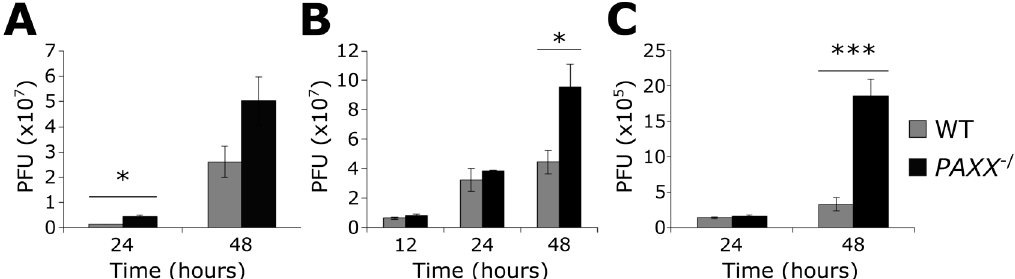
Figure 6. PAXX restricts production of infectious HSV-1 virions. WT or PAXX − / − RPE-1 cells were infected with HSV-1 at MOI ( A ) 0.01, or ( B ) 4, and infectious virions were titrated onto vero cells to determine virus titre (plaque-forming units; PFU); ( C ) WT or Paxx − / − MEFs were infected with HSV-1 at an MOI of 0.01, and infectious virions were titrated onto vero cells. Statistical significance, calculated by Student’s t -test, is denoted by stars—* = p < 0.05, *** = p < 0.01. n = 3. Error bars denote mean +/ − SEM.